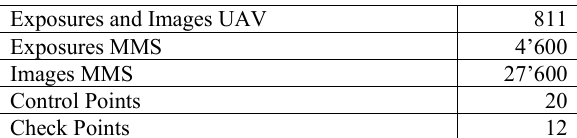
Table 2. Summary of the mapping campaign with the MMS